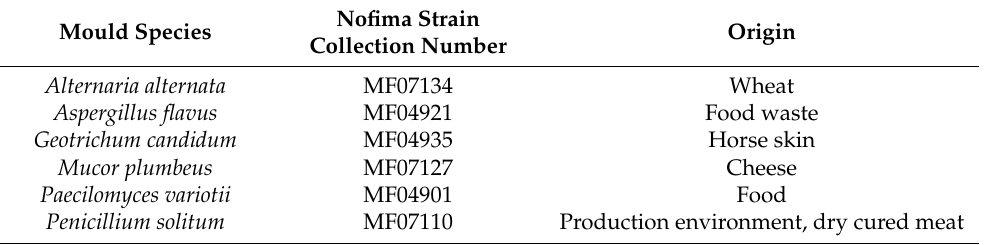
Table 1. Mould strains used in this